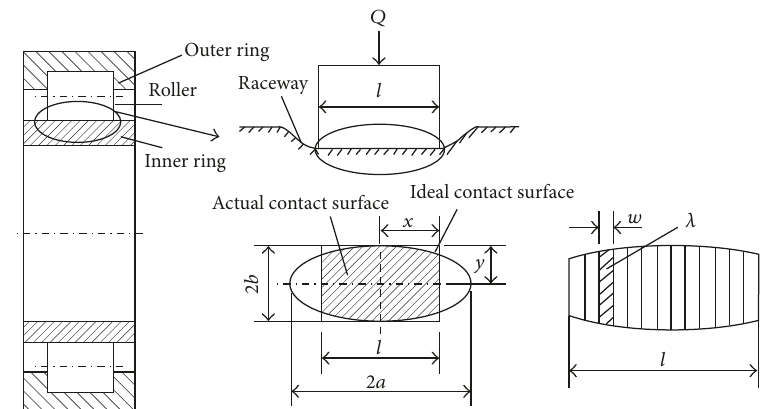
Figure 1: Schematic view of the roller bearing and elliptic contact